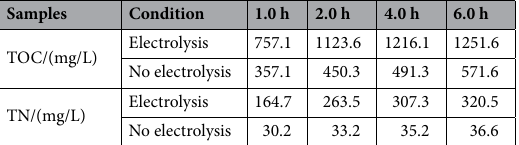
Table 6. Total N and total C content of electrolytic solution and